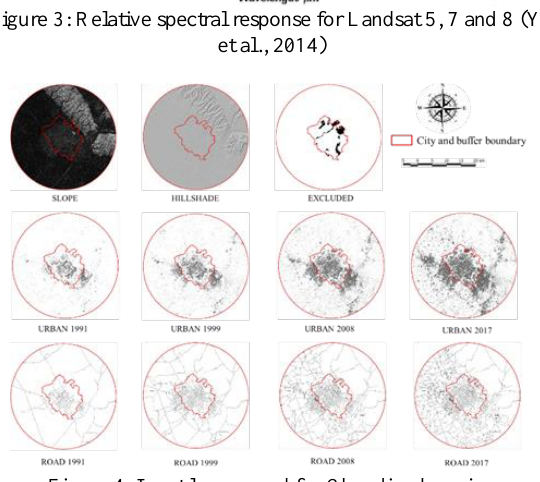
Figure 4: Input layers used for Chandigarh region